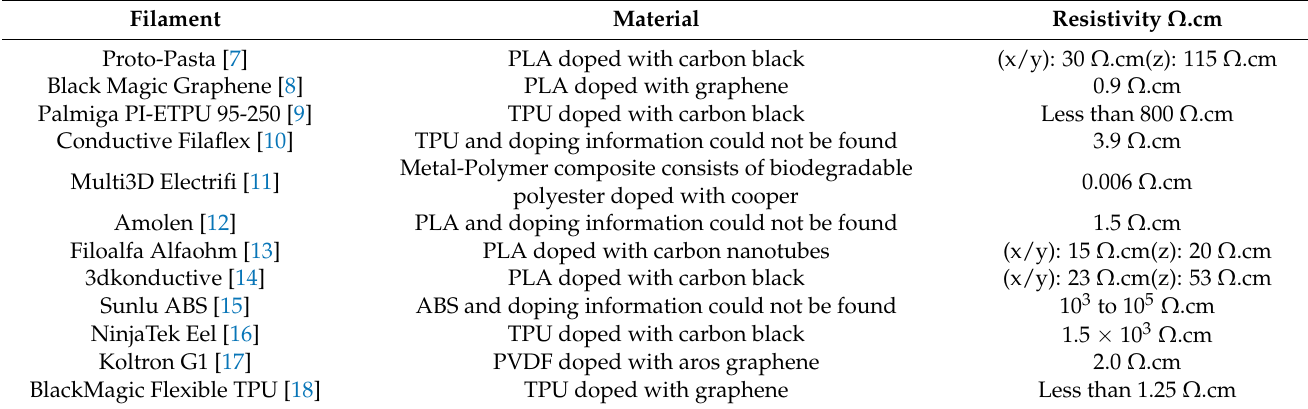
Table 1. Most popular commercially available conductive FDM